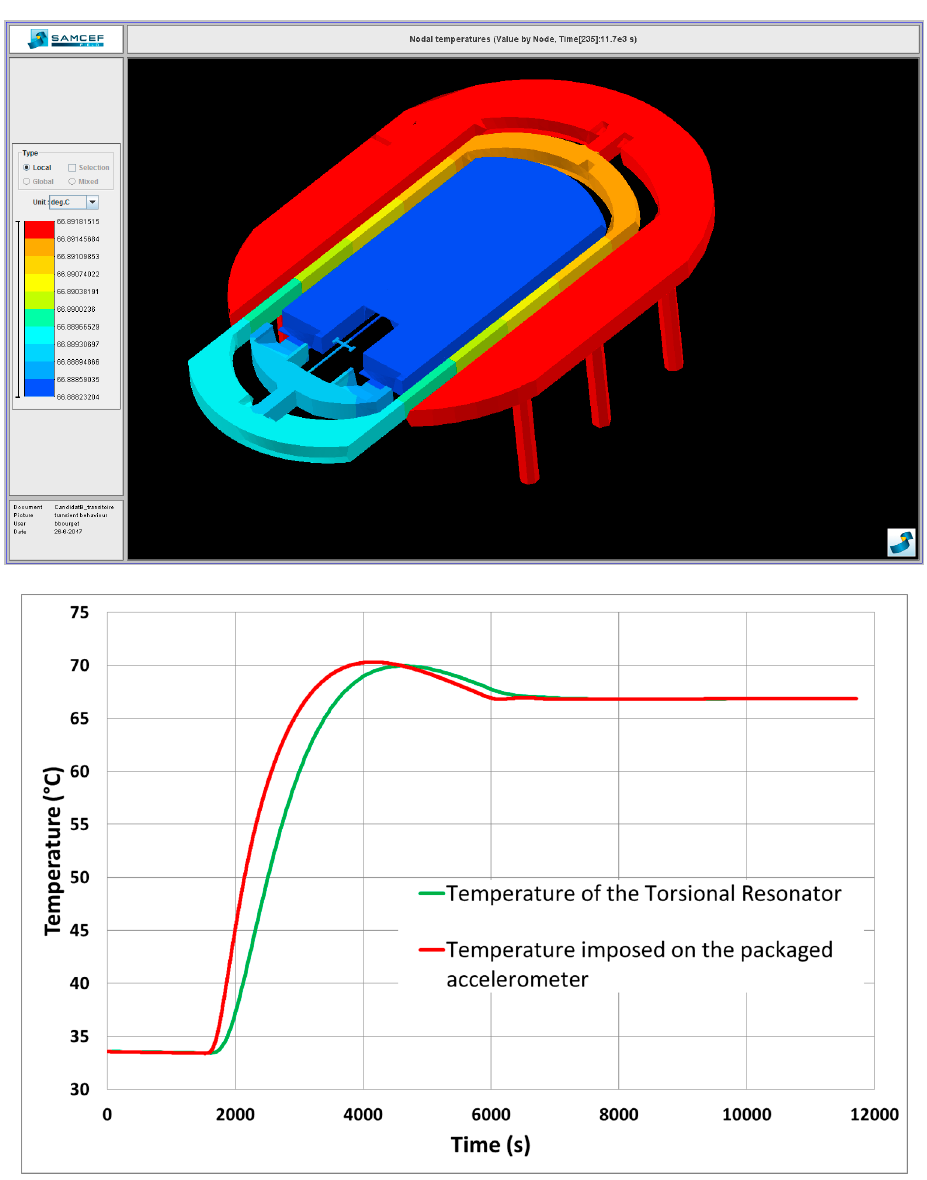
Figure 5. Thermal transient behavior of the accelerometer